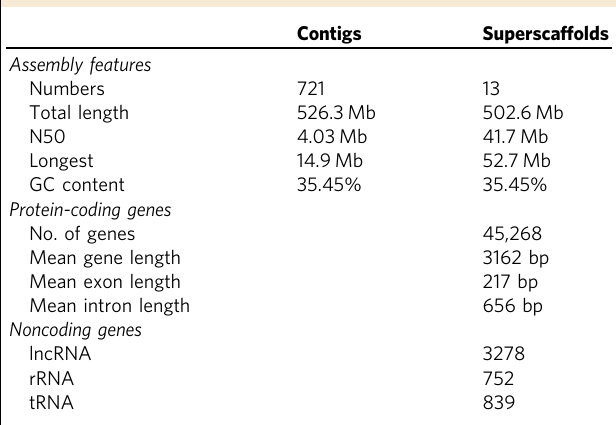
Table 1 Summary of genome assembly and protein-coding genes in S. tora .